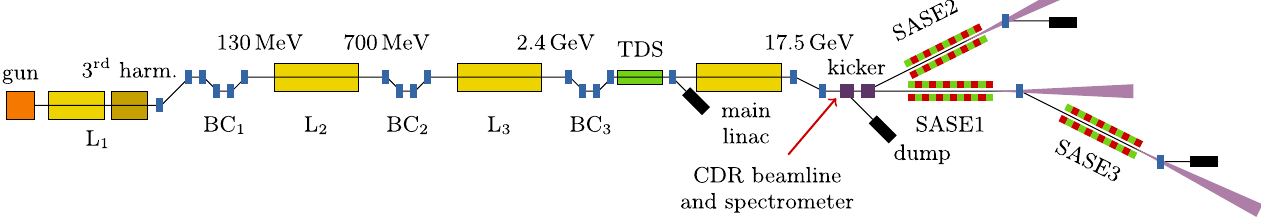
FIG. 2. Layout of the EuXFEL (not to scale). The CRD beamline and spectrometer are located upstream of two kicker-septa arrangements which are used to deflect bunches either to the beam dump upstream of the undulators or the SASE2